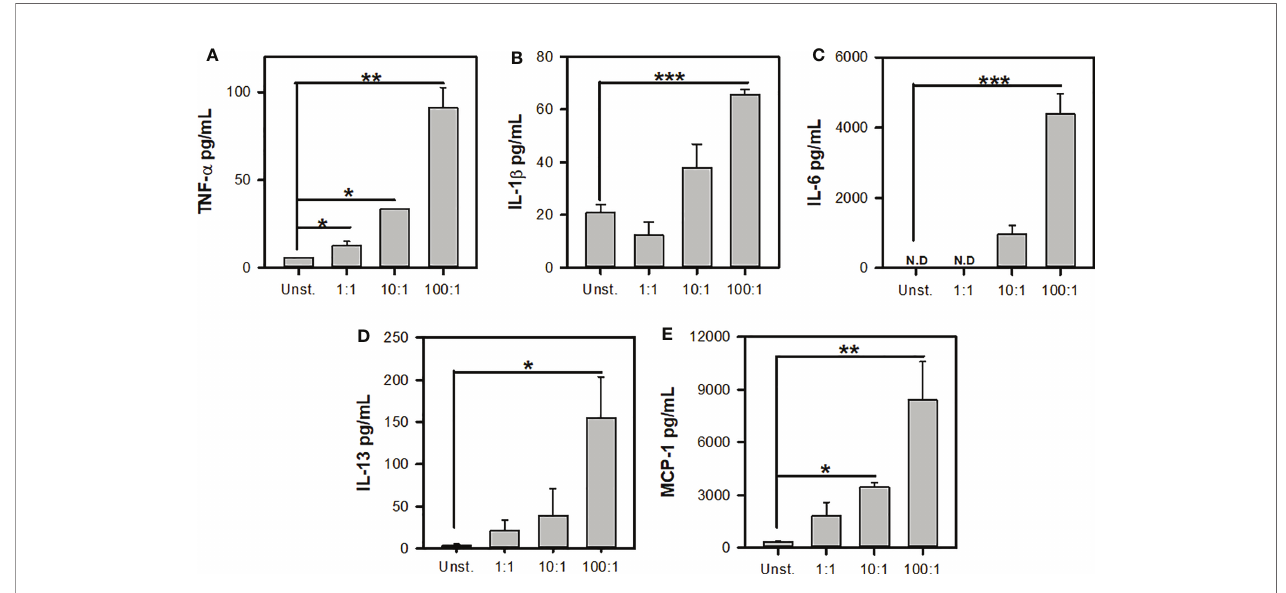
FIGURE 2 | Listeria monocytogenes induces de novo synthesis of cytokines by mast cells. 2.5x10 5 BMMC/0.25 mL of complete medium were stimulated with L.m for 24 h at the MOI indicated. Mediator levels were evaluated in culture supernatants by ELISA. (A) TNF- a , (B) IL-1 b , (C) IL-6, (D) IL-13 and (E) MCP-1. (The fi gure shows the sum of 3 independent experiments, n=3 per group and for each mediator; *p<0.05; **p<0.01; ***p<0.001; N.D, Not detected; One Way ANOVA